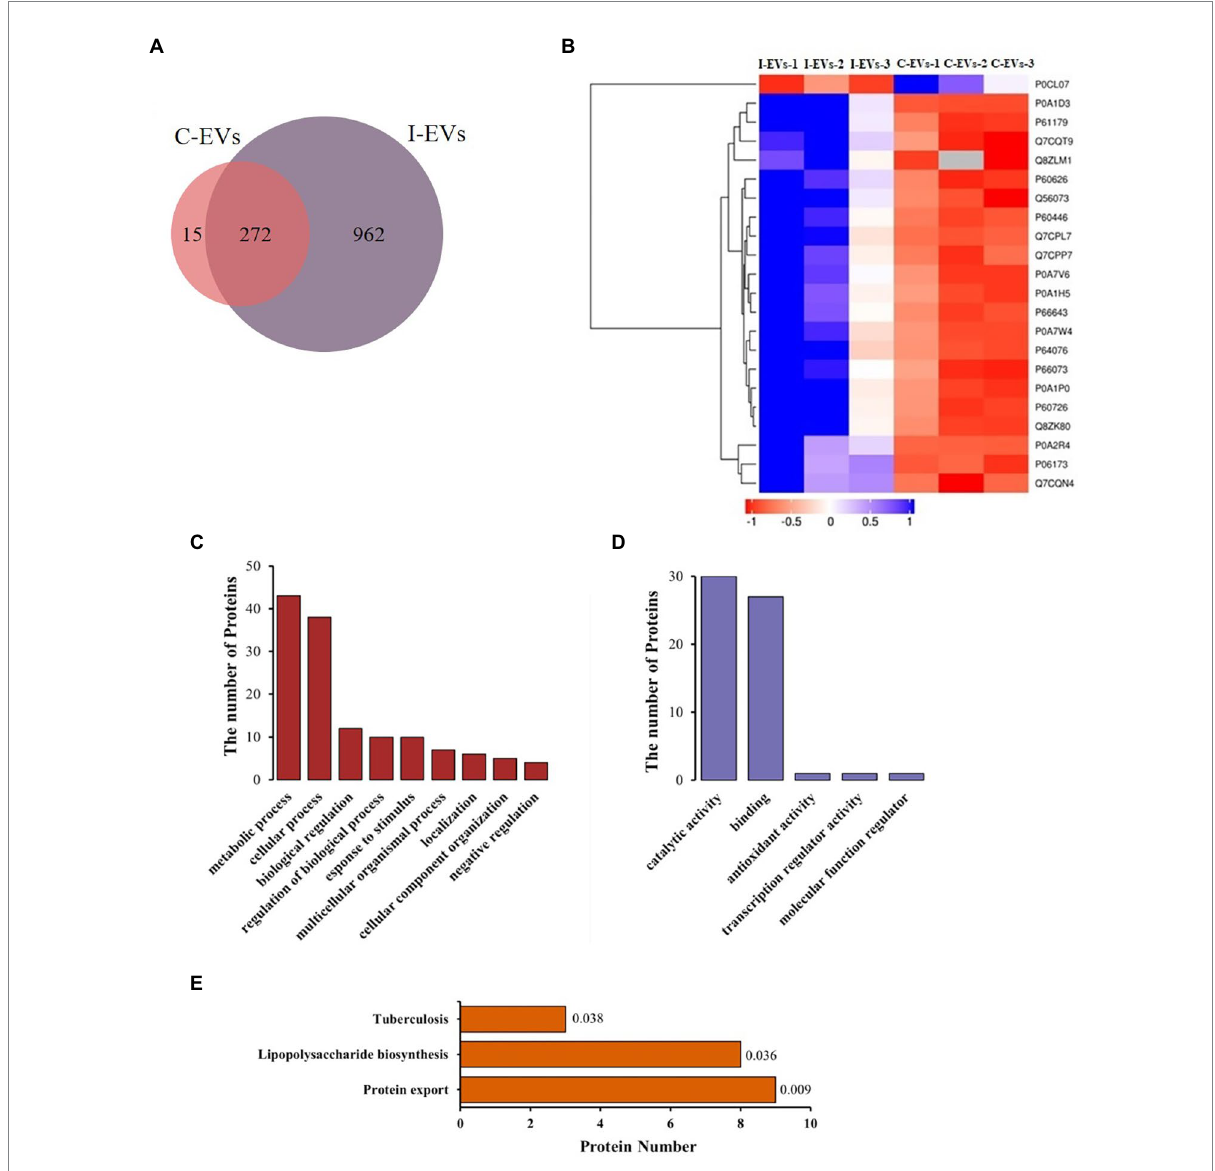
FIGURE 2 Label-free quantitative proteomics analysis of the isolated extracellular vesicles from uninfected or S. Typhimurium-infected Henle-407 cells at 8 hpi. (A) Venn diagram showing the detected proteins in two groups. (B) Heatmap illustrating the upregulated proteins among the overlapping proteins between the two groups. Additional information is available in Supplementary Table S1. (C,D) GO analysis showing the total protein counts stratified by biological process and molecular function. The S. Typhimurium protein database was used as a reference protein list for the fold enrichment analysis and a Bonferroni correction for multiple testing was used in each case. The top GO terms were chosen based on the statistical significance (the smallest p value), and the fold enrichment for each term is shown. (E) Enrichment map of KEGG pathways of the differentially abundant